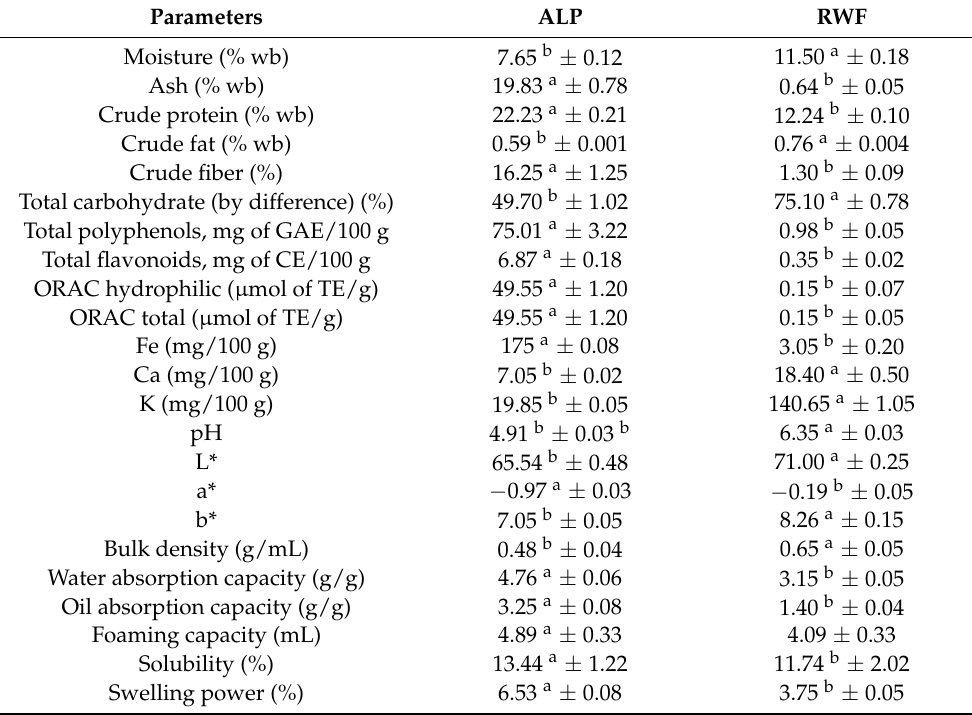
Table 2. Nutritional and functional properties of Aloe Vera leaf powder (ALP) and refined wheat flour